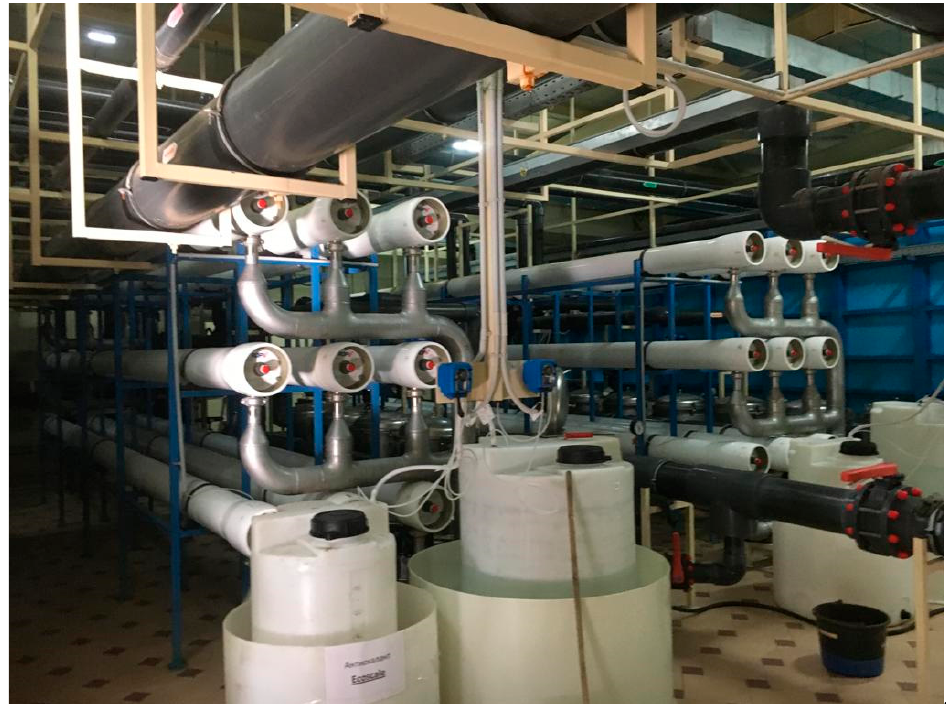
Figure 8. A 120 cubic meter per hour reverse osmosis membrane plant for production of drinking quality water from the ground water well intake in the Moscow region.